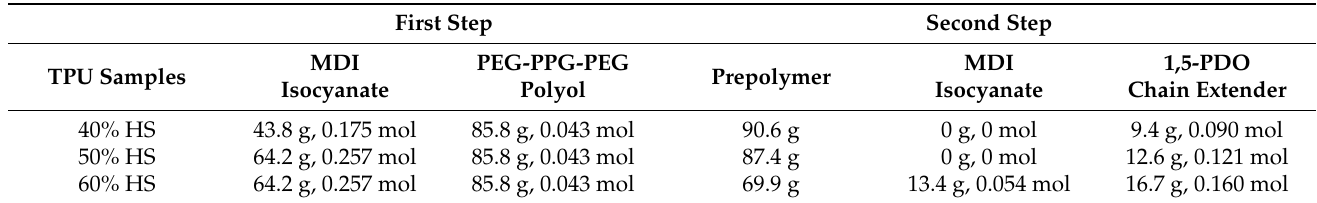
Table 1. The amount of each component used for the first and second step of TPU synthesis. First